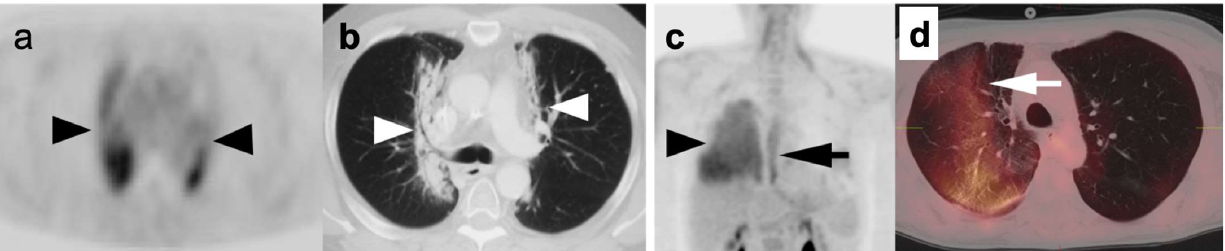
Figure 5. Post-radiation changes in the lungs in two patients: Case 1 ( a , b ): ( a ) Axial PET image demonstrates bilateral linear paramediastinal hypermetabolism ( black arrowheads ); ( b ) CT images of the chest (lung window) showing medial linear opacity (cicatricial atelectasis) and bronchiectasis ( white arrowheads ) resulting from chronic radiation fibrosis; Case 2 ( c , d ): ( c ) FDG PET scan shows diffuse hypermetabolism in the right lung ( black arrowhead ) and diffuse segmental hypermetabolism of the mid and distal esophagus ( black arrow ) on a MIP image; ( d ) The corresponding axial FDG PET-CT image of the chest shows corresponding hypermetabolic ground glass opacity in a geographic distribution in the right lung ( white arrow ) consistent with acute radiation pneumonitis. The patient had radiation of the esophagus that included a portion of the right lung for esophageal cancer. A myriad of benign tumors involving the chest can demonstrate focal FDG